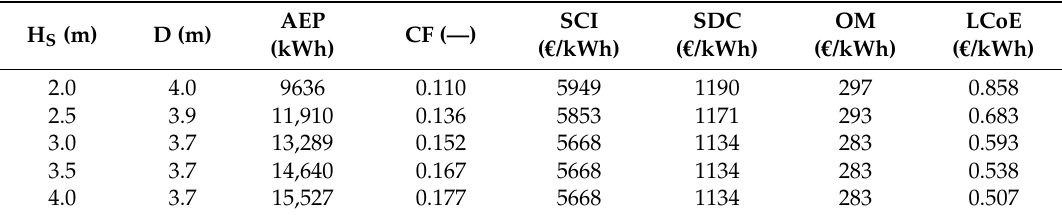
Figure 8. LCoE distribution versus maximum significant wave height at Alghero. Table 10. Incidence of maximum significant wave height on main data of WEC devices without the fully submerged mass at Alghero.